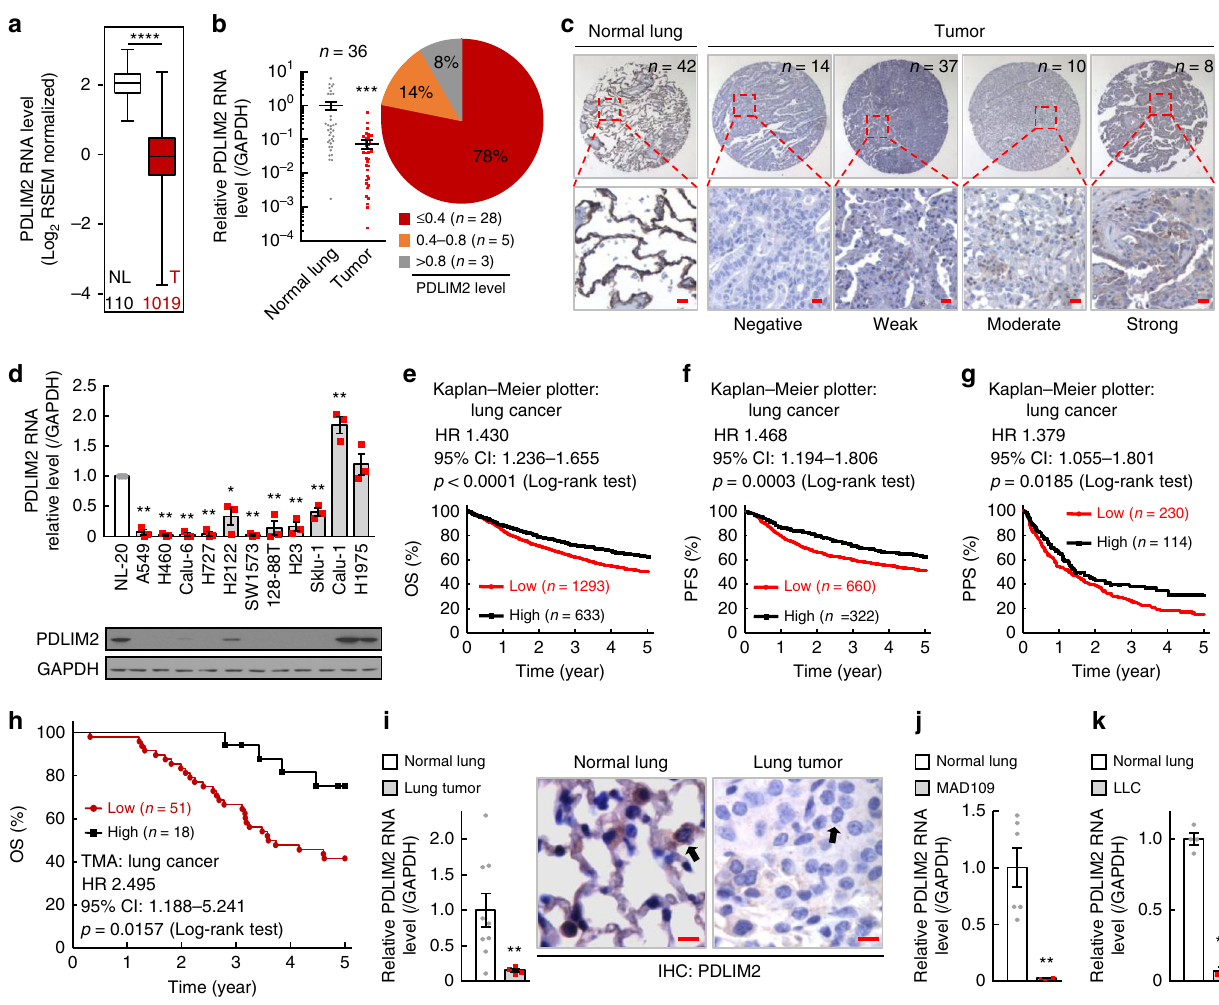
Fig. 1 PDLIM2 is repressed in lung cancer, associating with poor prognosis. a TCGA data showing decreased PDLIM2 in human lung tumor (T, red column) compared to normal lung (NL). Sample numbers are indicated. The bottom-most and topmost horizontal lines, the lower and upper hinges, and the middle line of the boxplots indicate the minimum and maximum values, the 25th and 75th percentiles, and the median, respectively. b qPCR showing decreased PDLIM2 RNA expression in human lung tumors compared to normal lung tissues from the same patients. Percentiles of lung tumors with PDLIM2 RNA expression levels ≤ 0.4, between 0.4 – 0.8, or >0.8 of the average in normal lungs are also shown. c Lung tumor tissue microarray showing PDLIM2 repression in human lung cancer. Scale bar, 20 μ m. d qPCR and immunoblotting (IB) showing decreased PDLIM2 in most human lung cancer cell lines (gray bars, n = 3). NL-20, normal human lung epithelial cell line ( n = 3). e – g Kaplan – Meier survival curve generated from Kaplan – Meier Plotter showing positive association of PDLIM2 expression in tumors with overall survival (OS, e ), progression free survival (PFS, f ), and post progression survival (PPS, g ) of lung cancer patients. h Kaplan – Meier survival curve on human lung tumor tissue microarray data in c showing positive association between PDLIM2 expression and patient survival. i qPCR and IHC staining analysis showing PDLIM2 repression in lung tumors induced by urethane in FVB/N mice ( n ≥ 4). Representative lung epithelial and tumor cells are indicated by arrows. Scale bar, 10 μ m. j qPCR analysis showing PDLIM2 repression in mouse lung cancer cell line MAD109 derived from a BALB/c mouse compared to normal lung tissues from BALB/c mice ( n ≥ 4). k qPCR analysis showing PDLIM2 repression in mouse lung cancer cell line LLC derived from a C57BL/6 mouse, compared to normal lung tissues from C57BL/6 mice ( n = 4). Student ’ s t test (two t ailed, unpaired) was performed in ( a , b , d , i – k ). Data represent means ± SEM in ( b , d , i – k ). * P < 0.05; ** P < 0.01; *** P < 0.001; **** P <